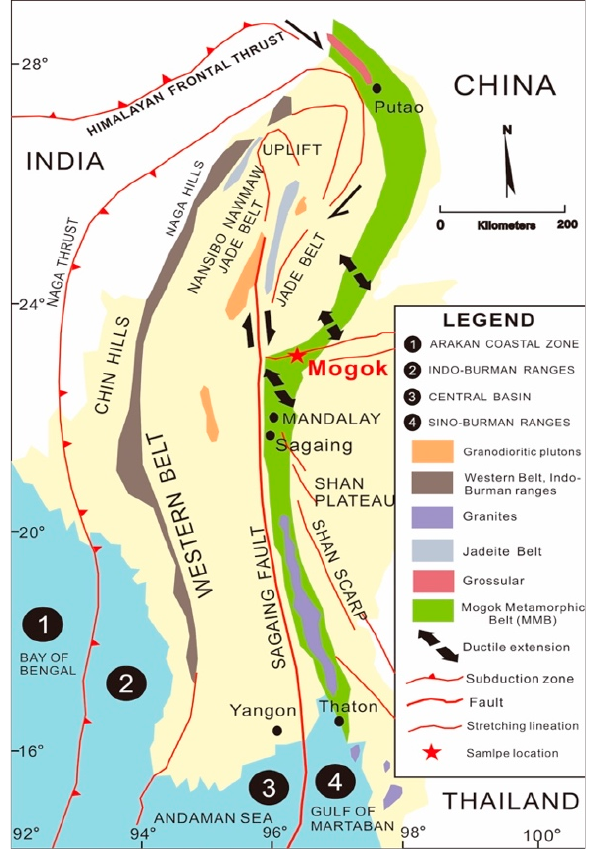
Figure 2. Simplified geological map of the Mogok metamorphic belt in Mandalay Province after Zaw [34].